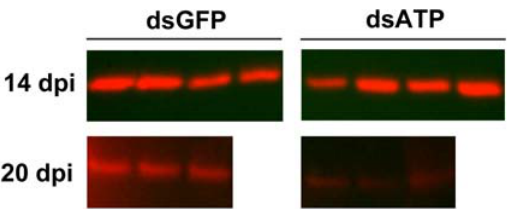
Figure 2. Protein level of ATP synthase β in Scaphoideus titanus injected with dsRNAs. Protein expression of ATP synthase β analyzed by western blots on insects (one insect sample per lane) injected with dsRNAs targeting green fluorescent protein (dsGFP) or ATP synthase β (dsATP) at 14 and 20 days post injection (dpi).